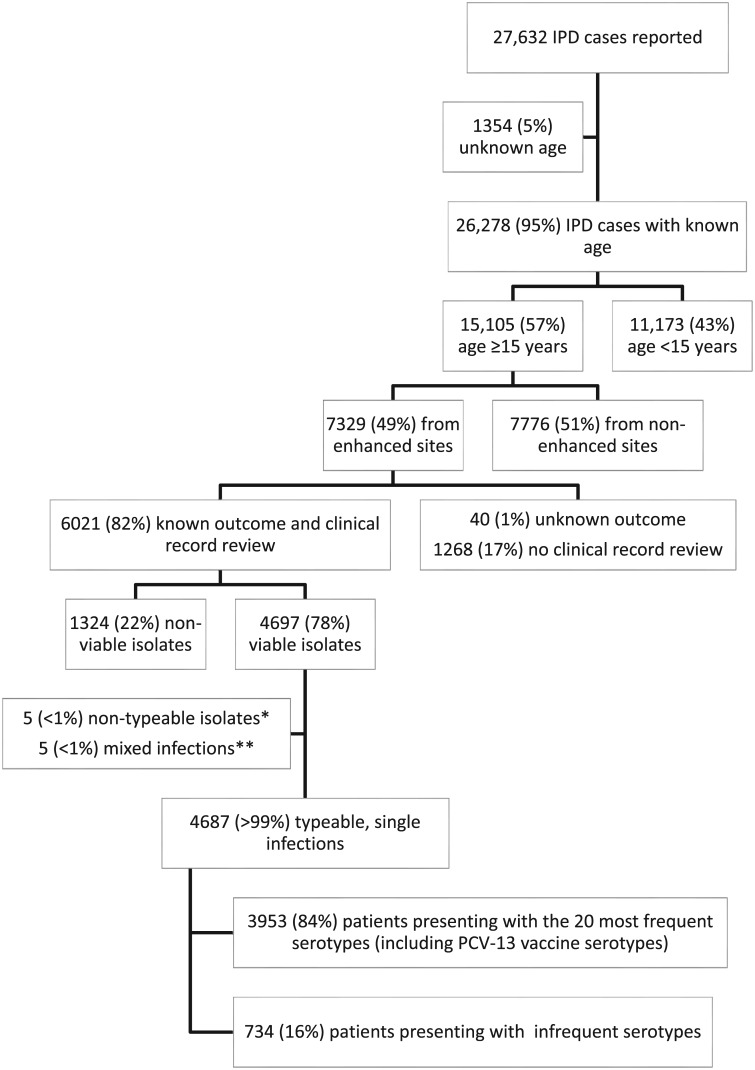
Flow diagram of patients with invasive pneumococcal disease (IPD) in South Africa, 2003–2008 and included in the analysis.*Pneumococci that did not have a capsule and could not be serotyped. **Isolates from patients that were simultaneously infected with two strains of pneumococci with different serotypes.